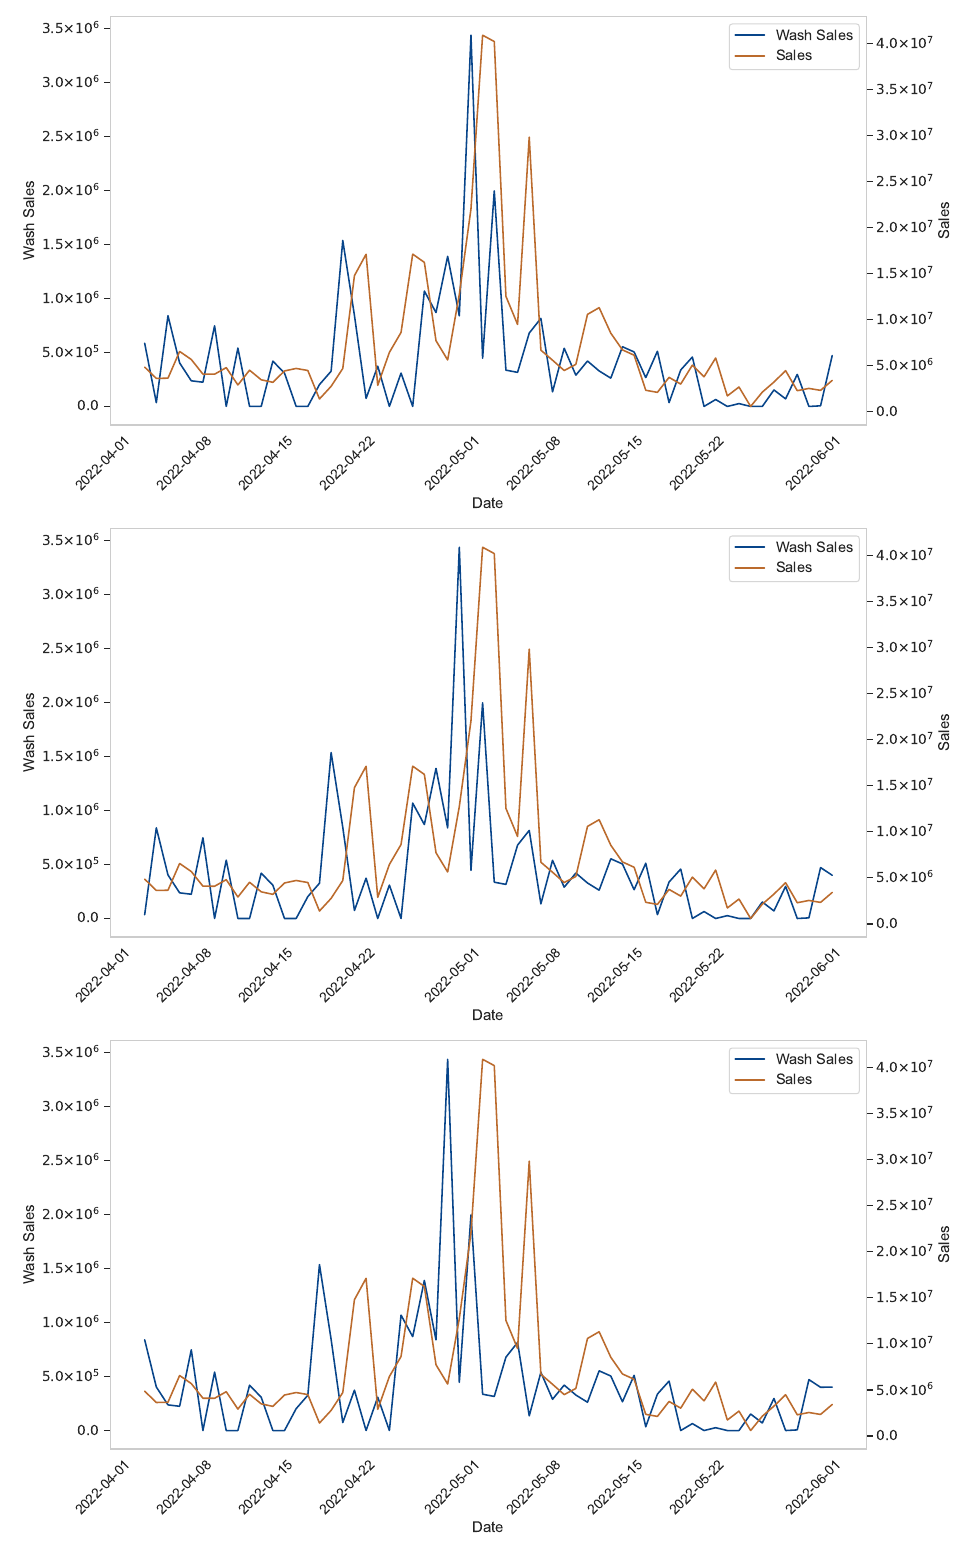
Figure 7. Cross-correlation of Wash Sales and Sales for BAYC when h = 0, h = 1, and h =